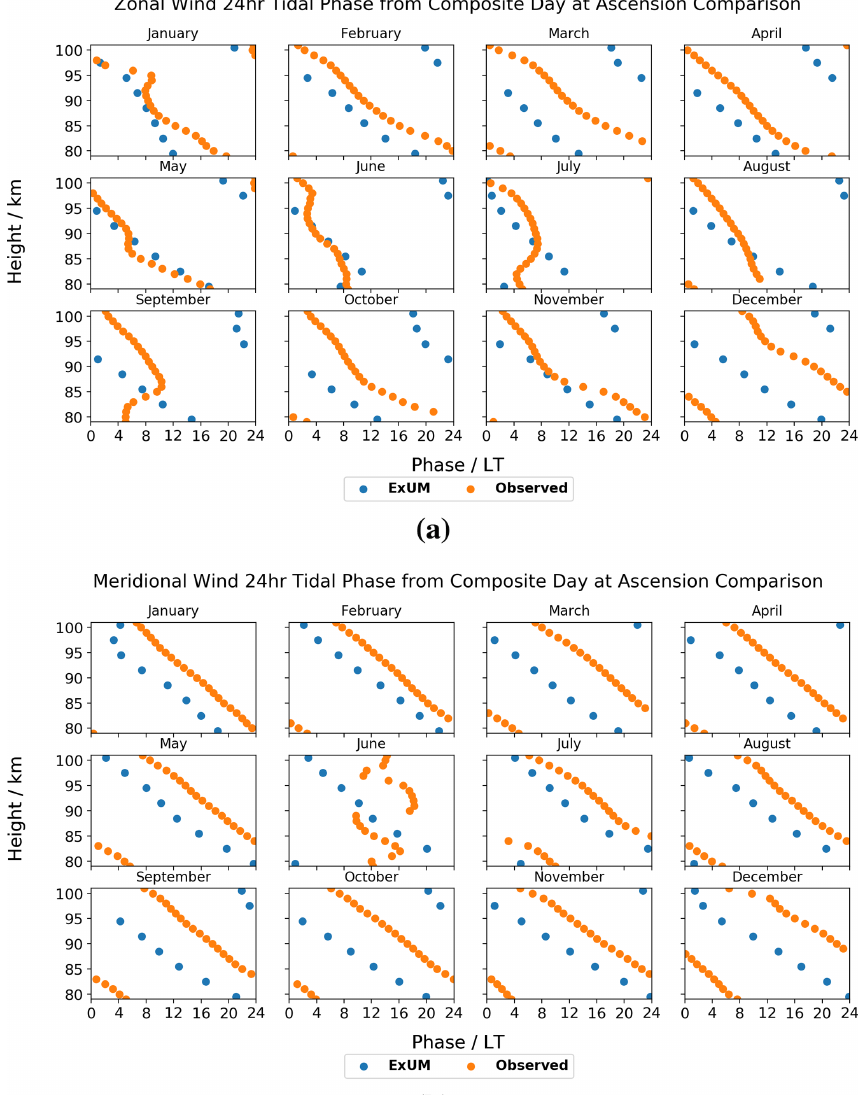
Figure 10. Phases for each month as a function of height for the (a) zonal ( u ) and (b) meridional ( v ) components of the diurnal tide at Ascension Island. Both the phases from the model (blue) and meteor radar (orange) are